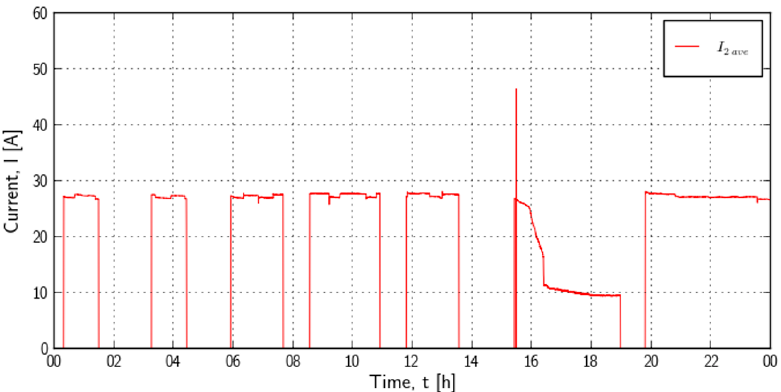
Figure 27. An example of the dry-running pump operation, visible through the PU2 load current change diagram.